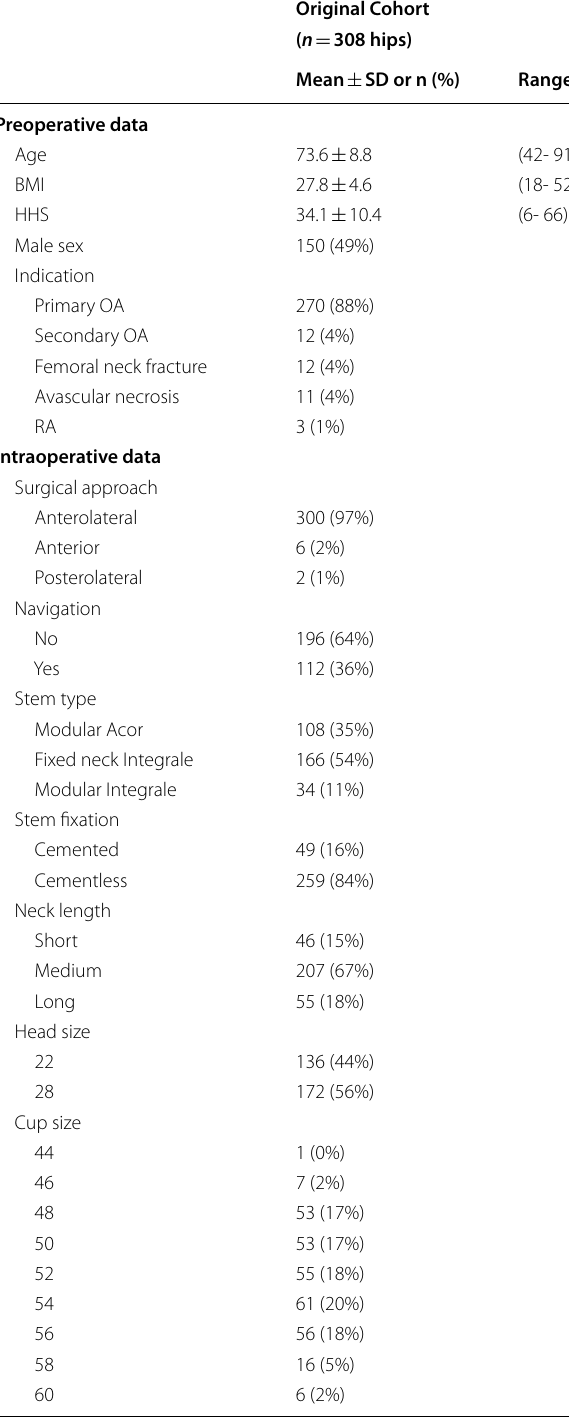
Table 1 Pre‑ and intra‑operative